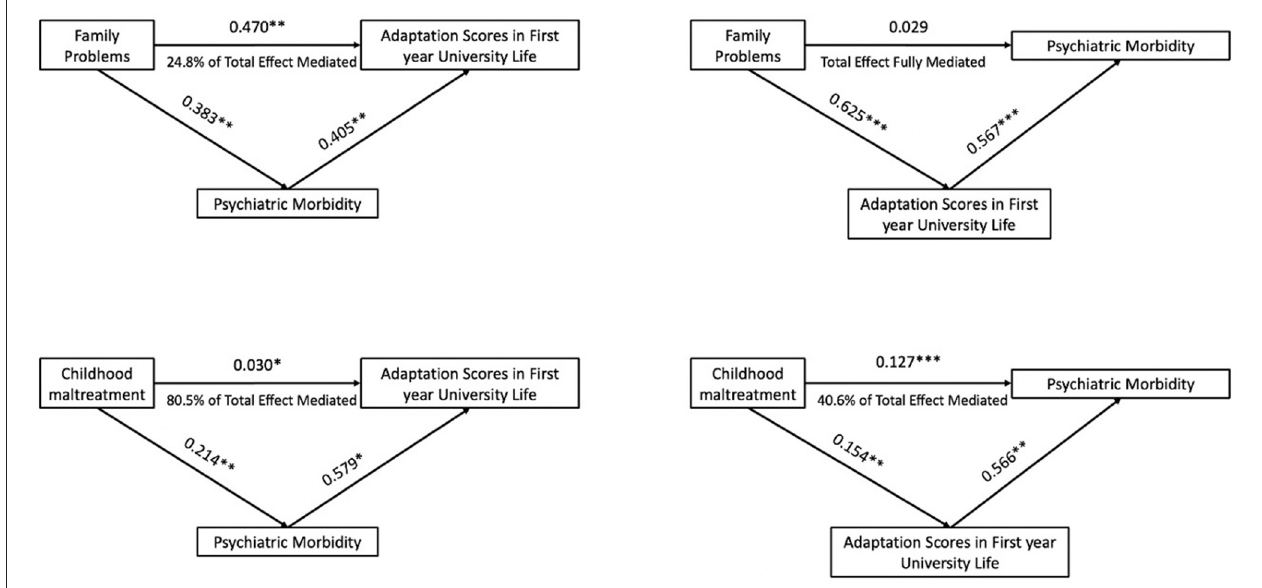
FIGURE 1 | Explanatory models of associations between childhood maltreatment and family problems in adaptation stress of first year university